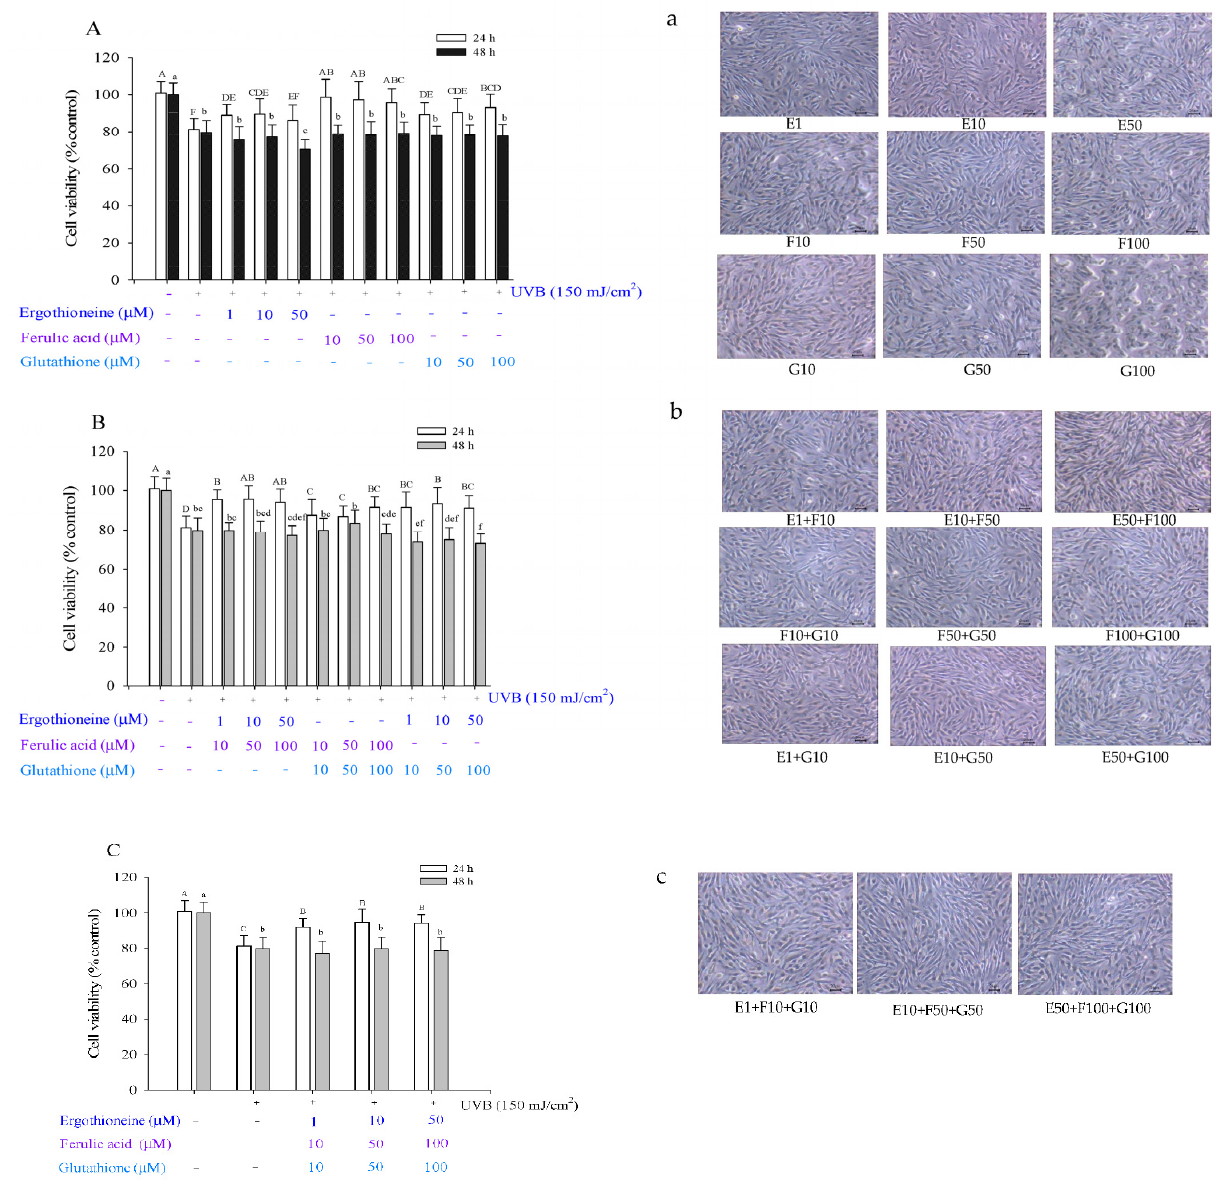
Figure 4. Viability of Hs68 cells after UVB irradiation for 24 or 48 h in the presence of a single ( A ), combination of two ( B ), or combination of three types of antioxidants ( C ), namely ergothioneine, ferulic acid, and glutathione. Effects of ergothioneine, ferulic acid, and glutathione on the cell image of Hs68 cells after UVB irradiation at 150 mJ/cm 2 for 24 h, in the presence of a single ( a ), combination of two ( b ), or combination of three types of antioxidants ( c ). Each value is expressed as the mean ± SD ( n ≥ 3). Different letters indicate significant differences among treatments ( p < 0.05).